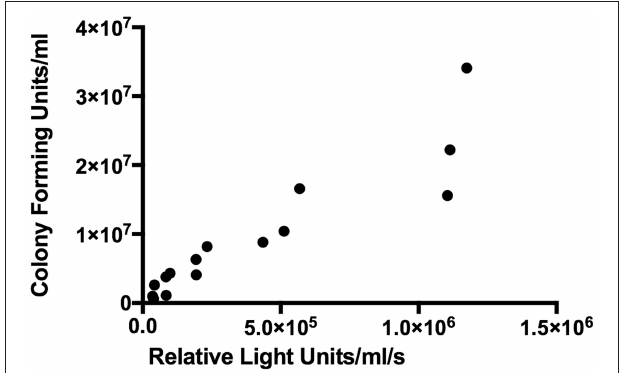
FIGURE 3 | Correlation between colony forming units and luminescence of BCG-GFP-LuxFO in liquid 7H9 medium. n = 15 pairs of observations. Spearman rank correlation coefficient r = 0.9714 (95% CI: 0.9112–0.9910; p < 0.0001).